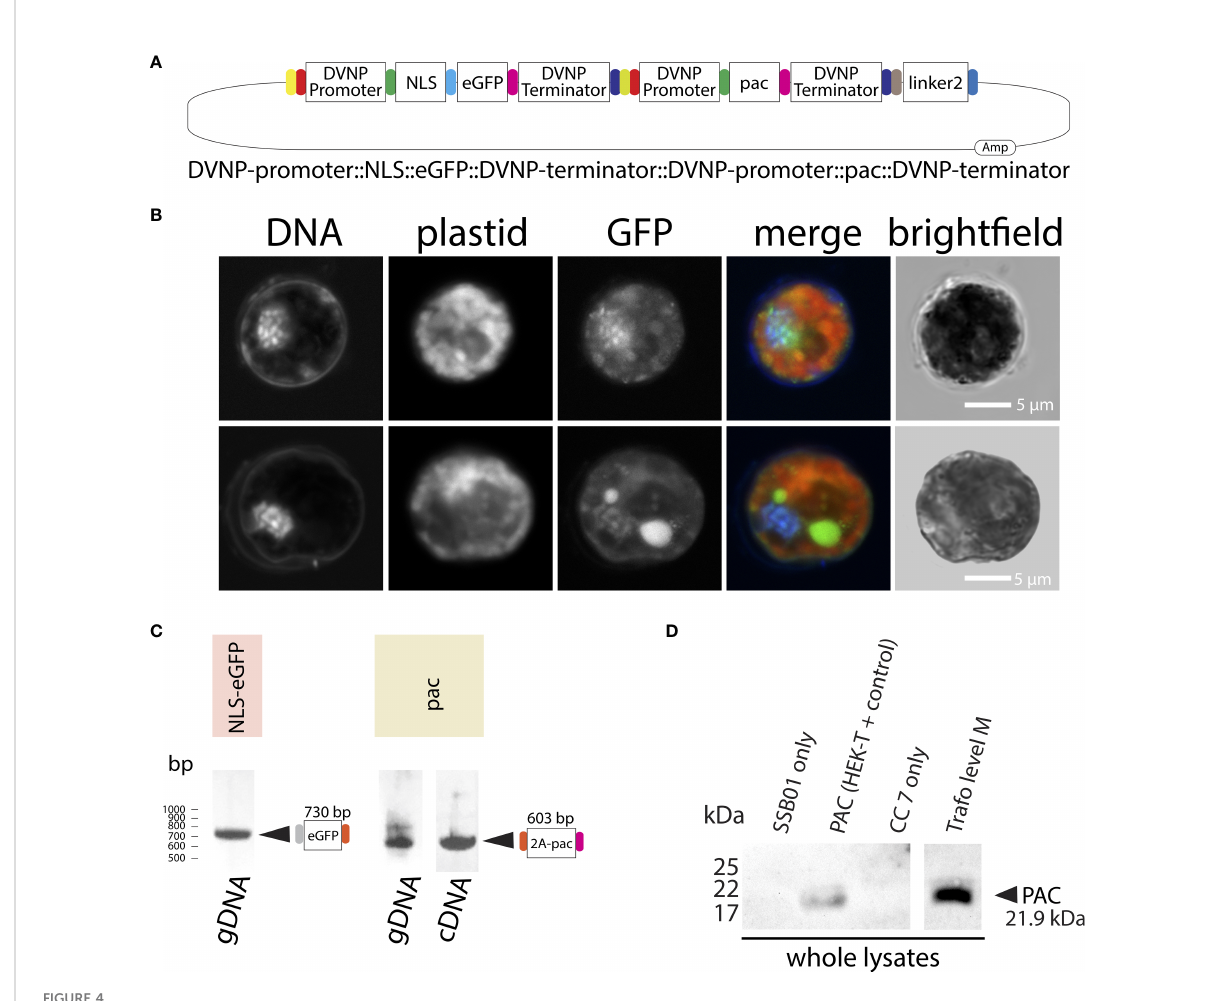
FIGURE 4 (A) Graphical representation of the level M transformation vector comprising DVNP-promoter::NLS-eGFP::DVNP-terminator level 1 position 1, DVNP-promoter::pac::DVNP-terminator level 1 position 2 and end linker 2 modules. (B) Confocal images of transformed SSB01 cells showing expression and translocation of GFP to the nucleus in the presence of the expression vector. Note: the large GFP-positive structure in one of the cells is the result of strong auto fl uorescence of an accumulation body. (C) PCR results for eGFP and (RT-)PCR results for pac in transformed cells. (D) Anti-PAC Western blot showing that transformed cells express PAC post transformation. For a whole blot see: Supplementary File